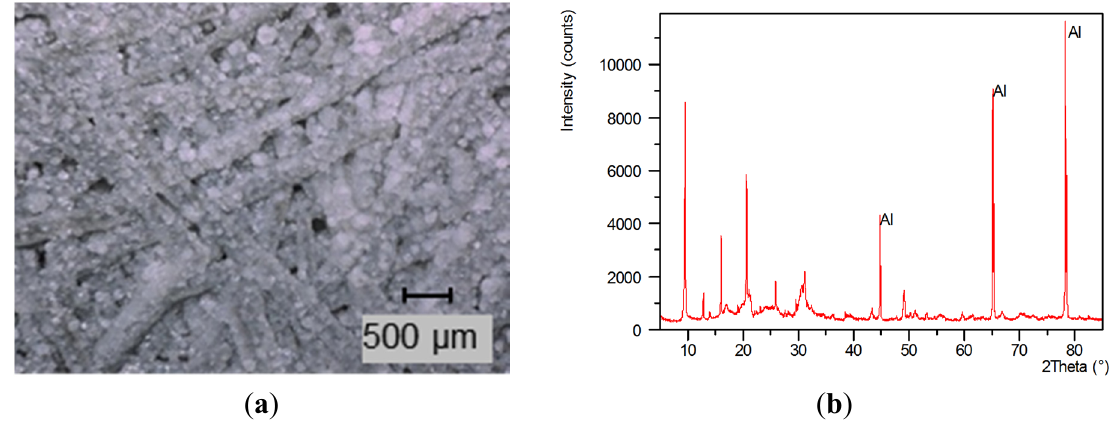
Figure 1. ( a ) Microscopic view of a fiber-SAPO-34 sample; ( b ) XRD pattern of